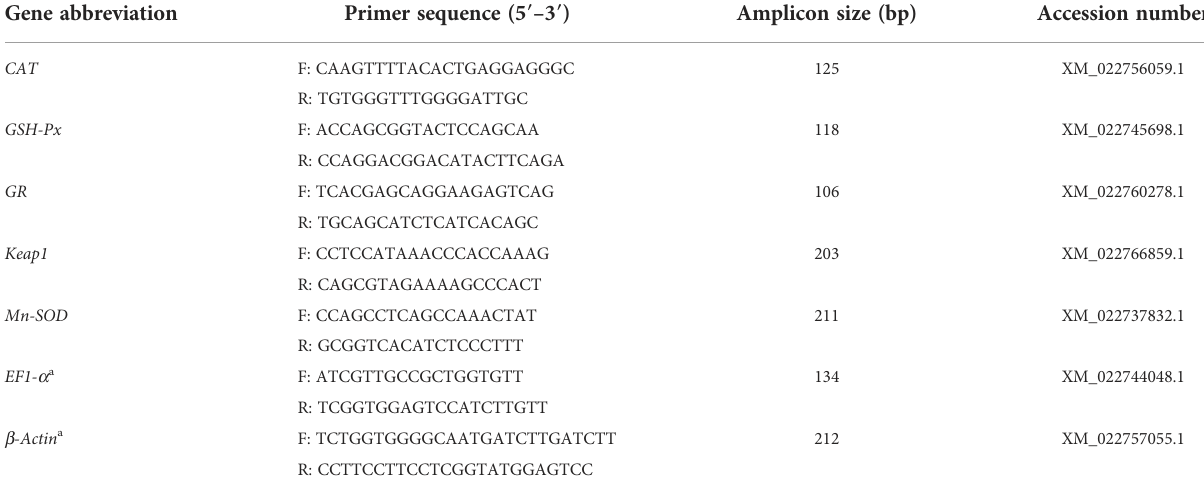
TABLE 2 Primers used for real-time